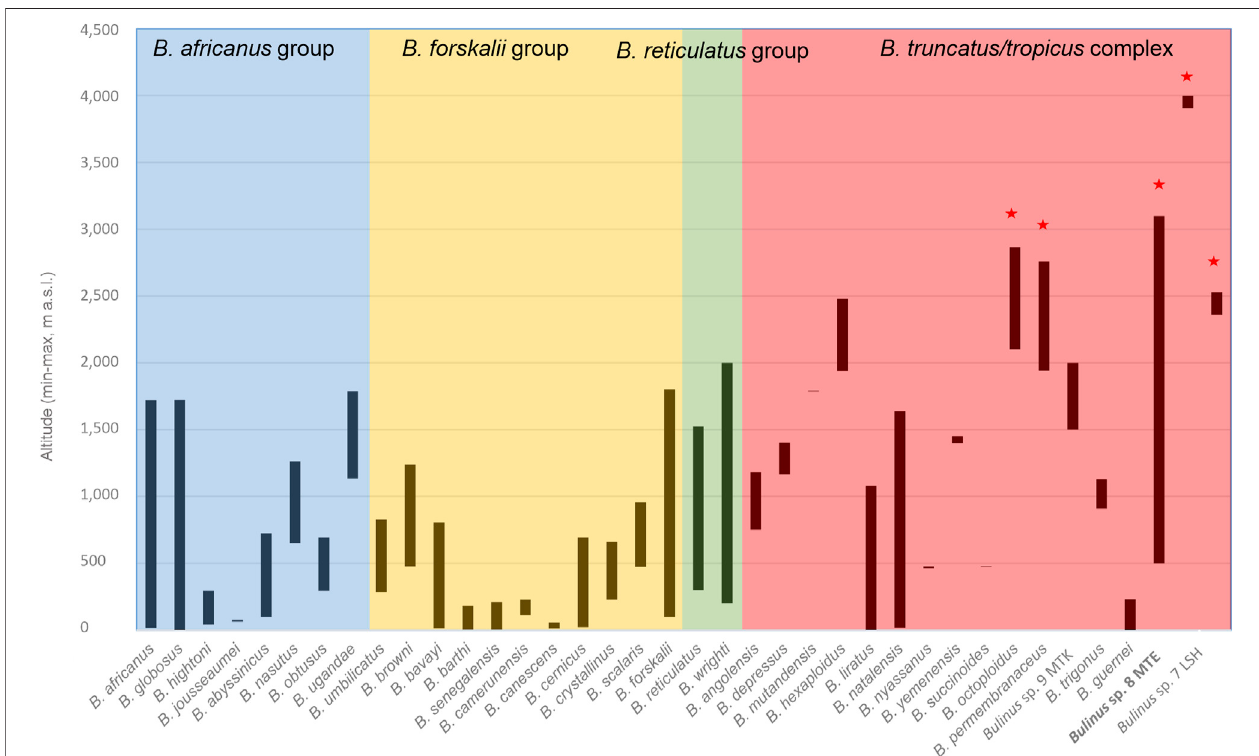
FIGURE 3 | Altitudinal distribution of members of the Bulinus groups (highlighted with colors) throughout their entire range compiled from various literature and collectionsources.Redstarsmarkspeciesoccurringinextremealtitudesabove2,500 ma.s.l.Notetheextraordinaryhighoccurrenceof Bulinus sp.8MTEonMt.Elgon, Uganda. This species is new to science and is only distantly related to the B. truncatus/tropicus complex. Further details on altitudinal ranges can be found in the Supplementary Tables S2, S3